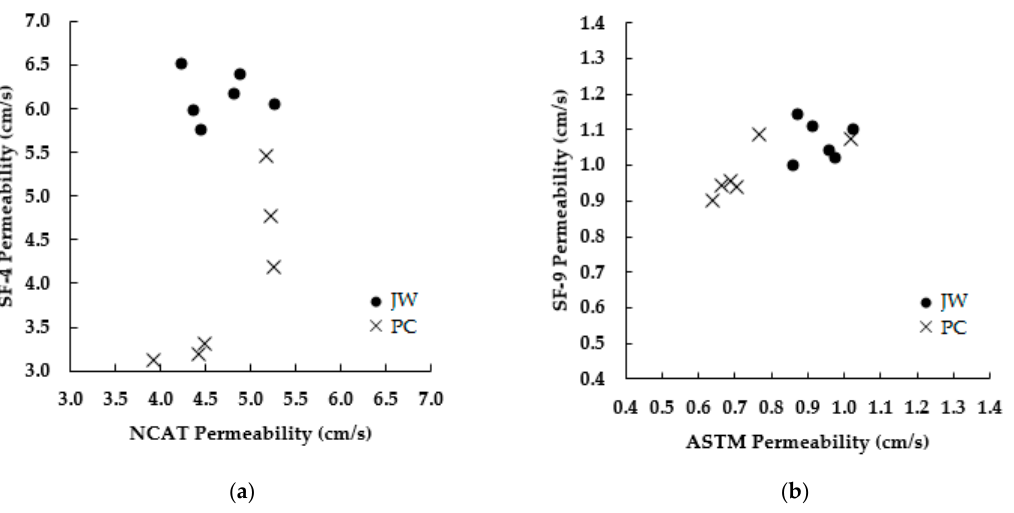
Figure 10. Scatter plots of permeability obtained by ( a ) NCAT and SF-4 methods, and by ( b ) ASTM and SF-9 methods on the north and south test locations on the JW and PC pavements.